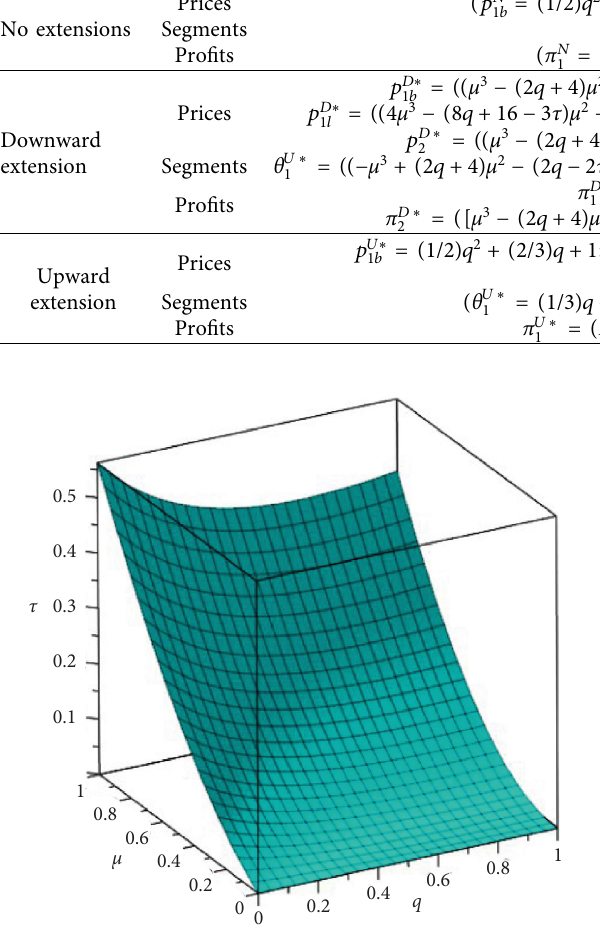
Figure 11: The changes of N ( μ , q )